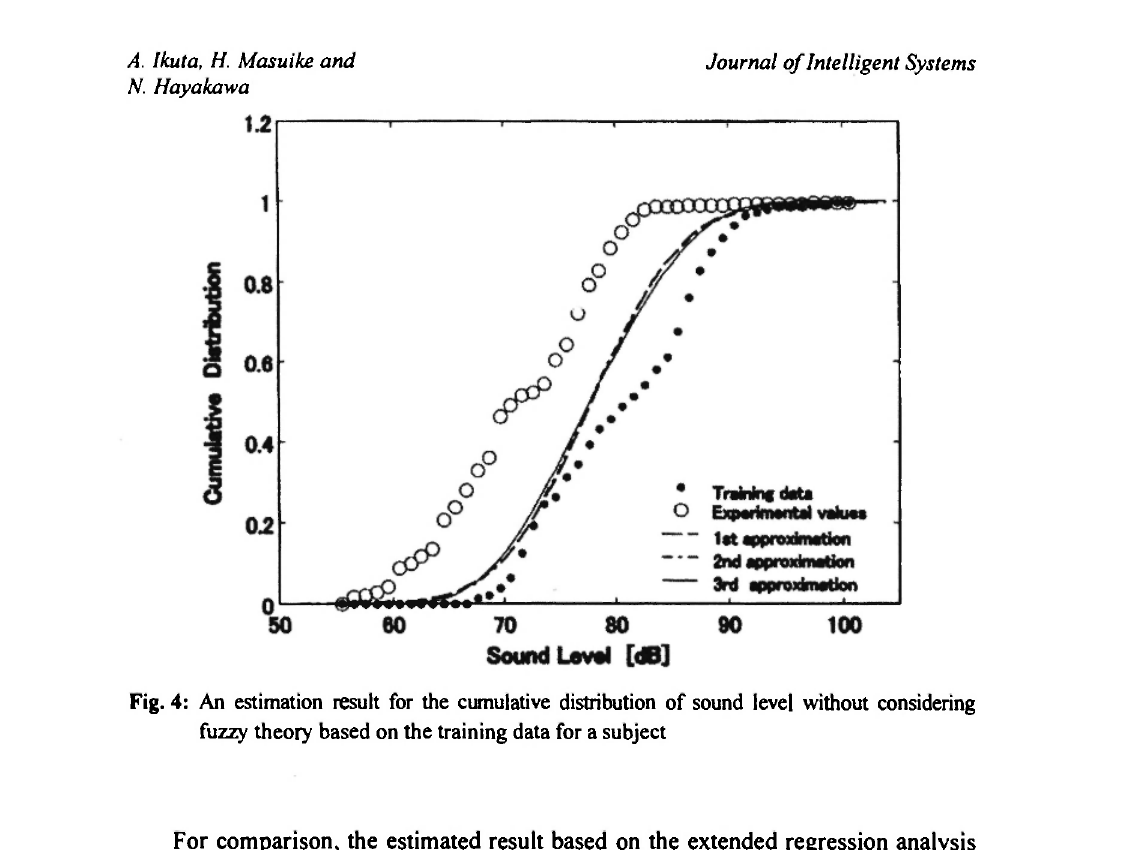
Fig. 4: An estimation result for the cumulative distribution of sound level without considering fuzzy theory based on the training data for a